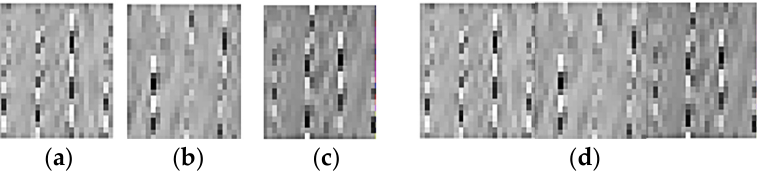
Figure 7. Example of the generated vibration image with inner bearing fault from the data described in Section 2.1.1: ( a ) feature map of channel 1 (vertical direction), ( b ) feature map of channel 2 (horizontal direction), ( c ) feature map of channel 3 (axial direction), and ( d ) the composite image.